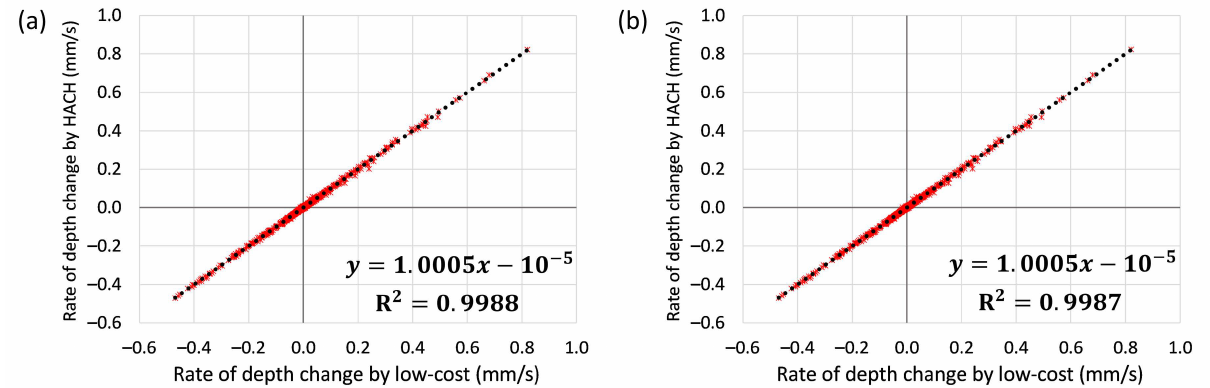
Figure 9. Comparing the rate of depth change (trend) between low-cost and HACH probes: ( a ) with only one offset calibration before installation; and ( b ) by using the low-cost sensor data after automated